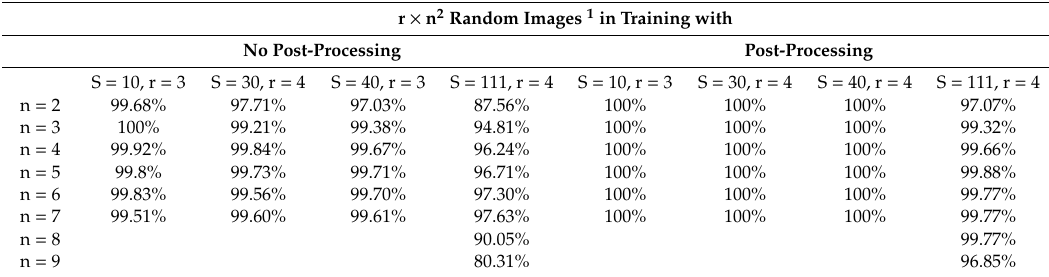
Table 1. Classification results of the experiments on the Brodatz database for sets of 10, 30, 40, and 111 images. The best results reached with and without post-processing are highlighted by bold text. r × n 2 Random Images 1 in Training with No Post-Processing Post-Processing